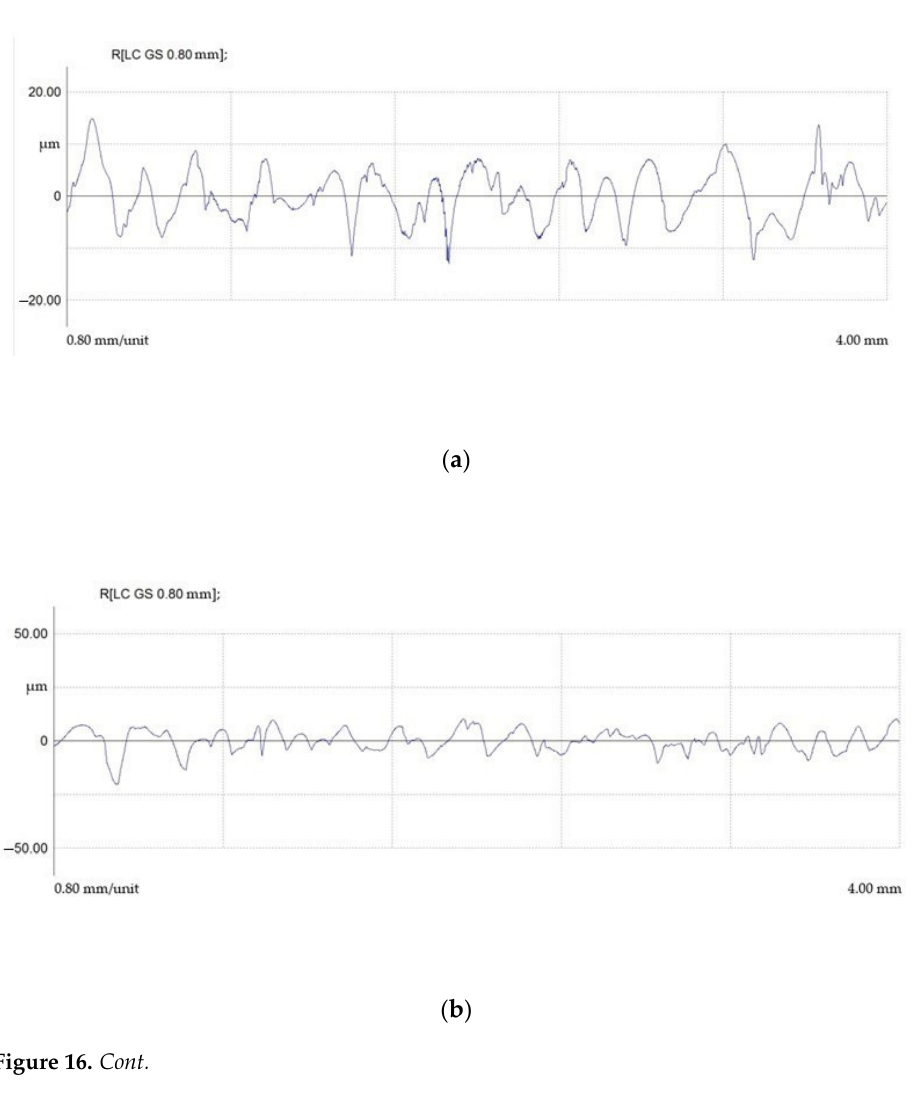
Table 7. Surface roughness after EDM.